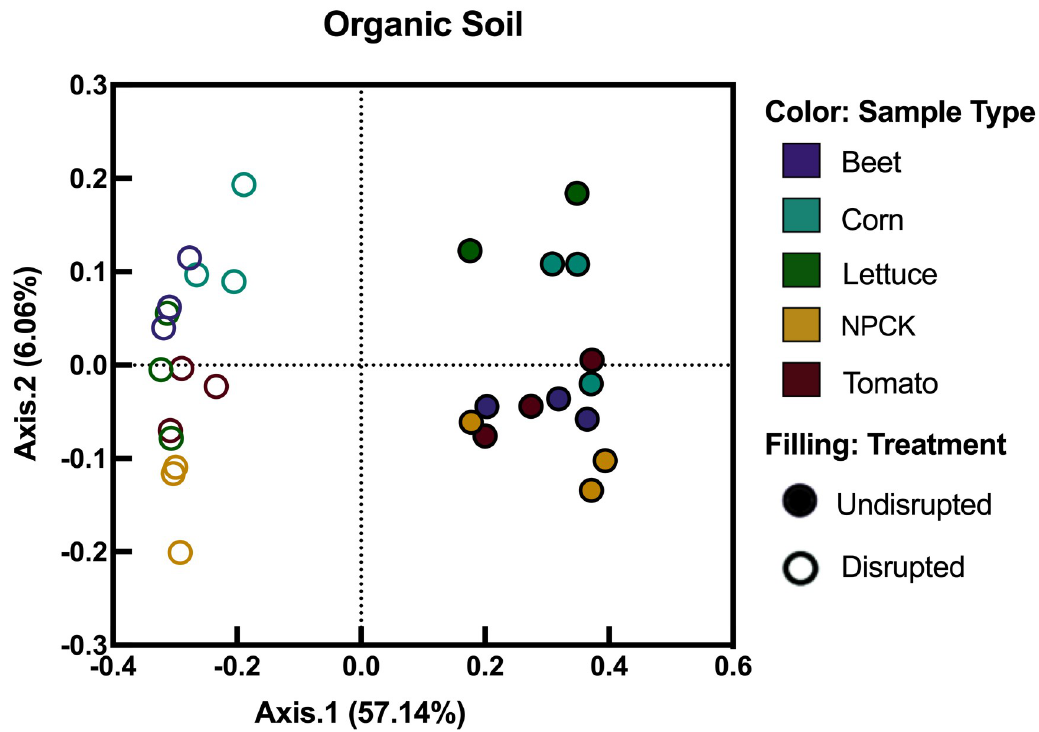
Fig 3. Principal coordinate analyses (PCoA) of rhizobacterial communities after crop growth in undisrupted and disrupted organic agroecosystem soils. Colored circles indicate samples treated with disruption, whereas hollow circles indicate undisrupted samples, respectively. Purple, teal, green, yellow, or red color represents rhizospheric samples from beet, corn, lettuce, NPCKs or tomato samples, respectively. Figure created using GraphPad’s Prism (Vers. 8.2.1).